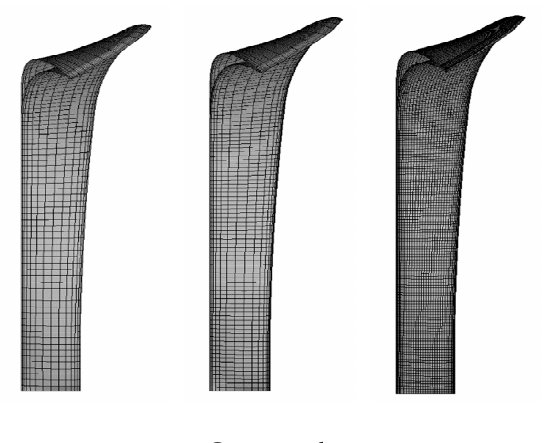
Figure 3. Schematic diagram of the blade structure grid.